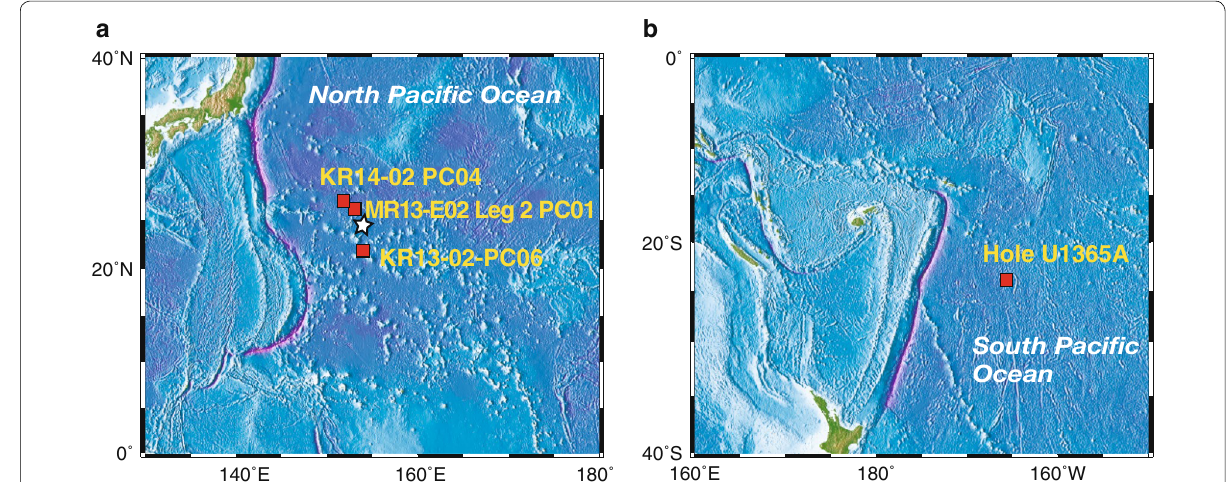
Fig. 1 Location of the studied cores. a Piston cores in the western North Pacific Ocean. Star: Minamitorishima Island. b IODP Hole U1365A in the South Pacific Ocean